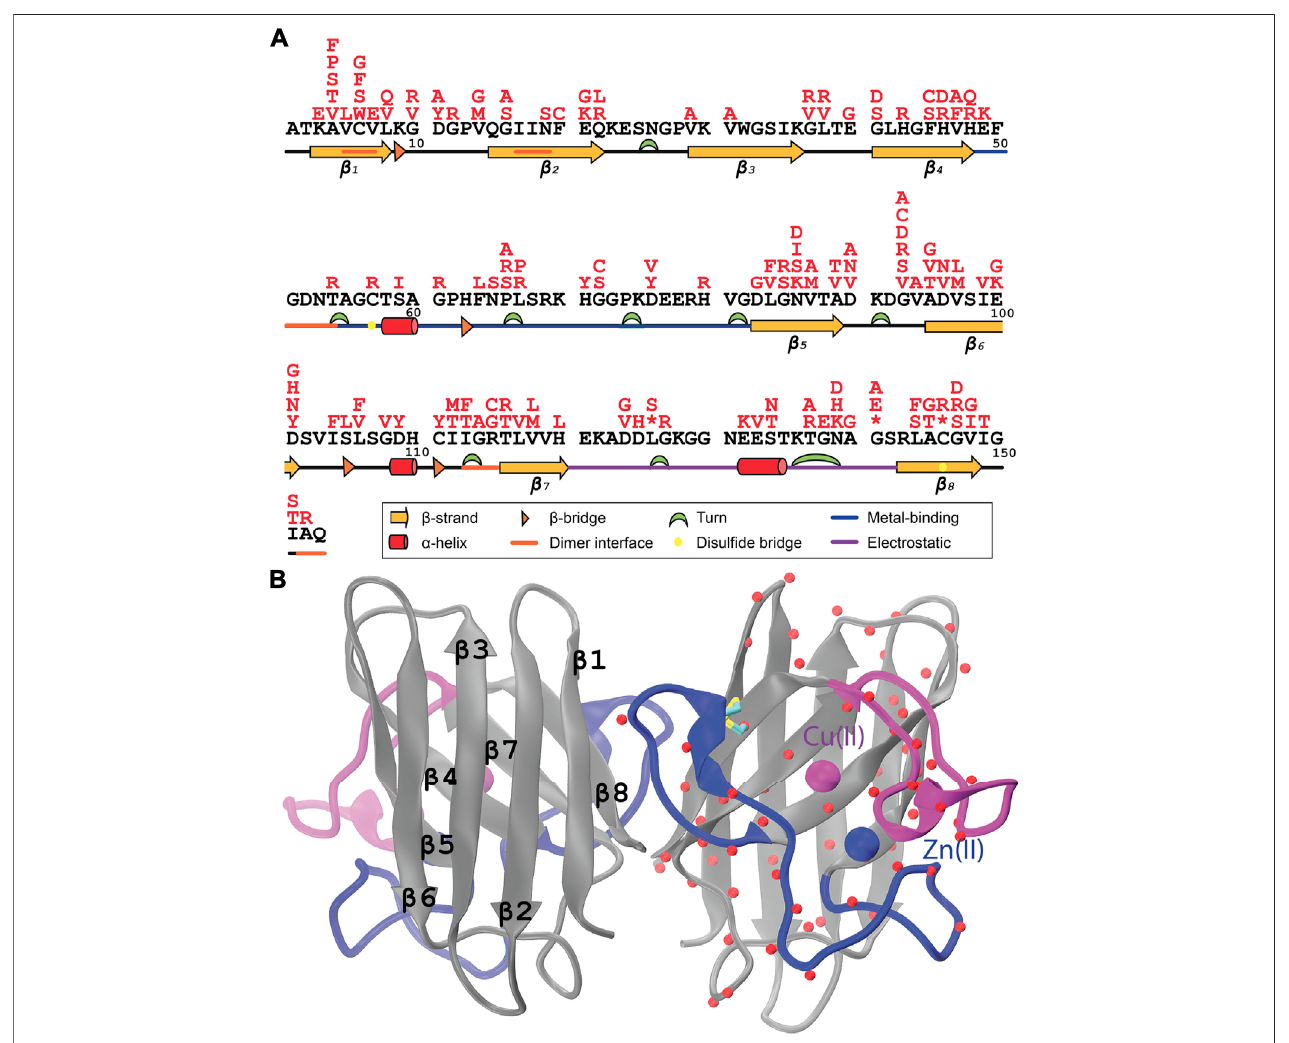
FIGURE1 |(A) ALS-associatedmutations (red) were shown onthe SOD1 protein sequence (black), (B) C α atoms of themutated positions were illustrated on one of the subunits of the human SOD1 dimer (PDB ID: 2V0A) (Strange et al., 2007). Metal-binding and electrostatic loops were colored in blue and purple for each subplot,